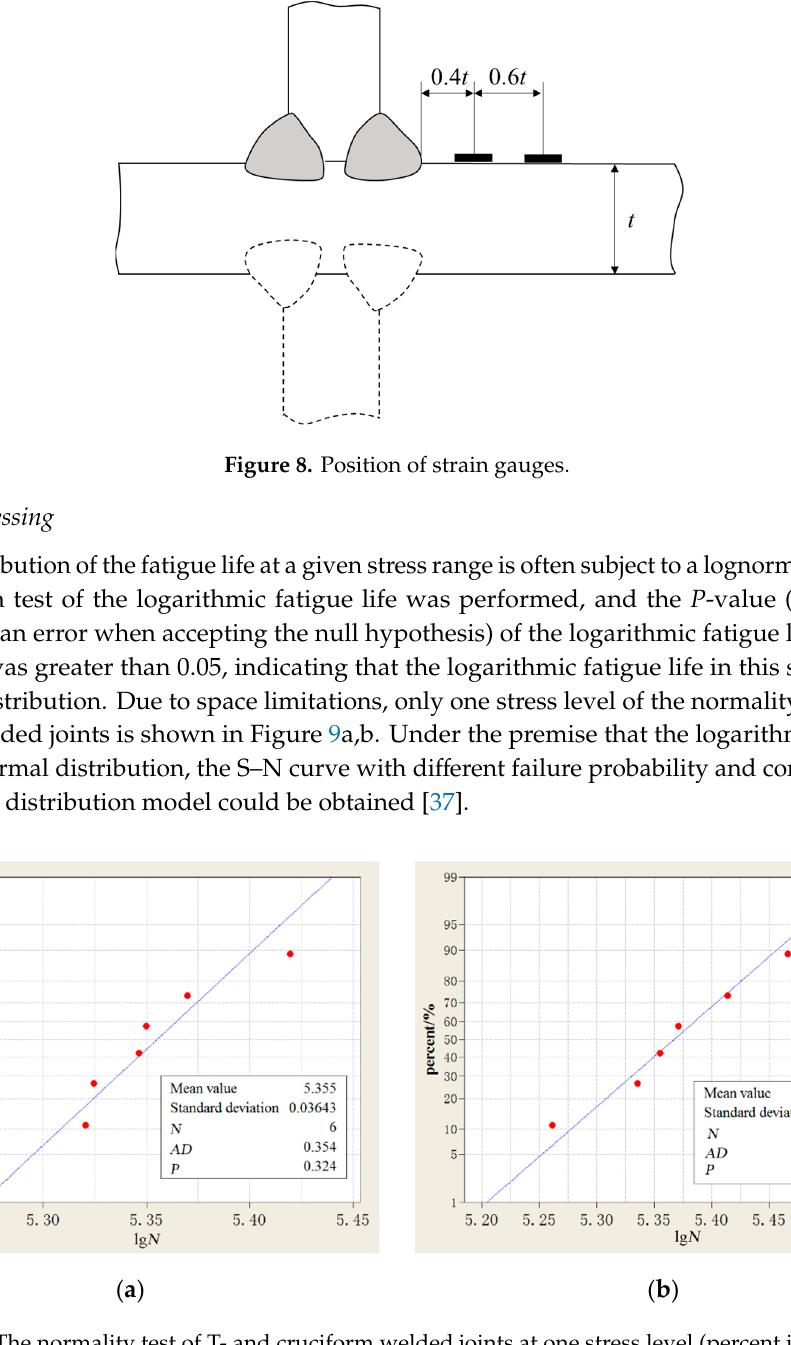
Figure 9. The normality test of T- and cruciform welded joints at one stress level (percent is a normal distribution cumulative distribution function): ( a ) T-welded joints and ( b ) cruciform welded joints.